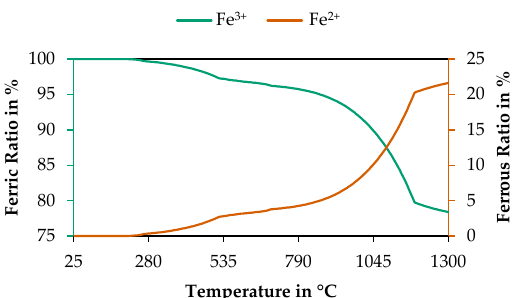
Figure 8. Ferric and ferrous ratio according to thermochemical simulation.